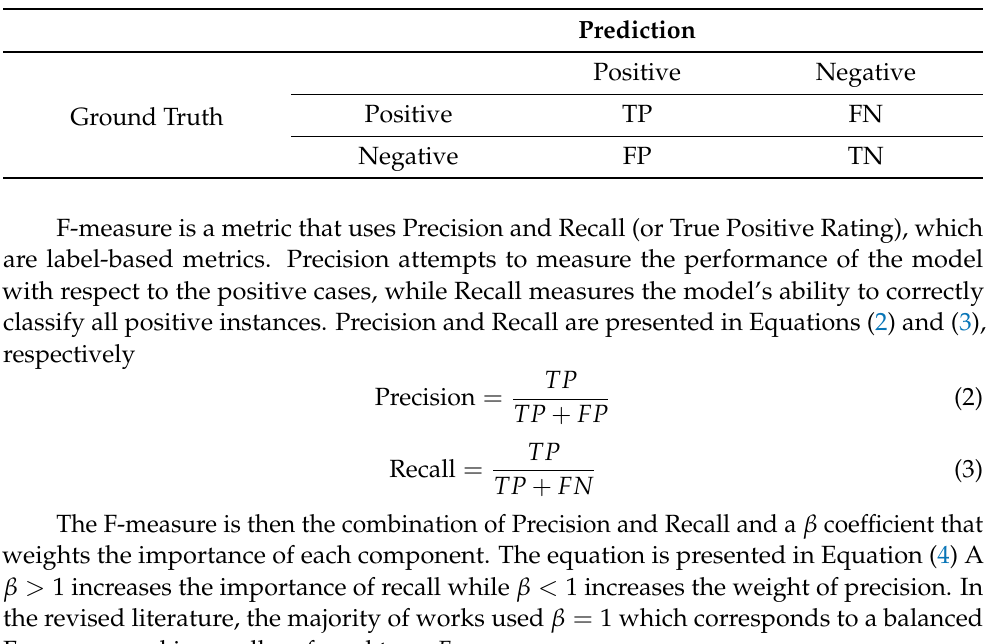
Table 1. Example of a confusion matrix for binary